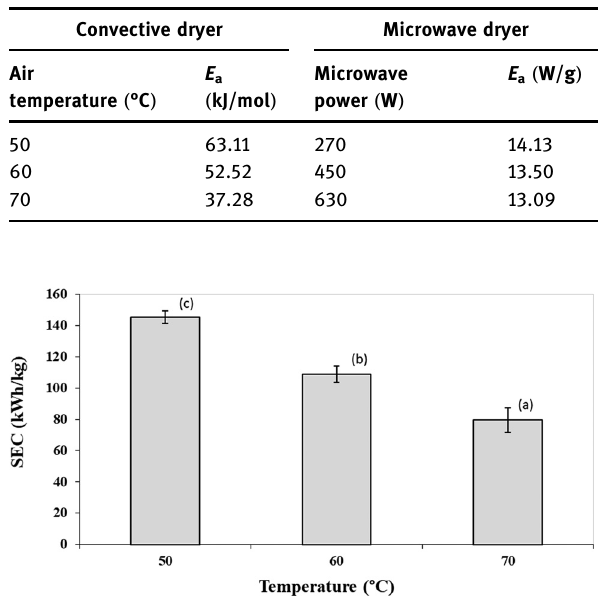
Figure 6: Values of SEC in CV for di ff erent drying air temperatures. The bars represent mean values and the corresponding standard deviations. Bars with the same letter are not signi fi cantly di ff erent according to ANOVA and Tukey test ( p < 0.05 )